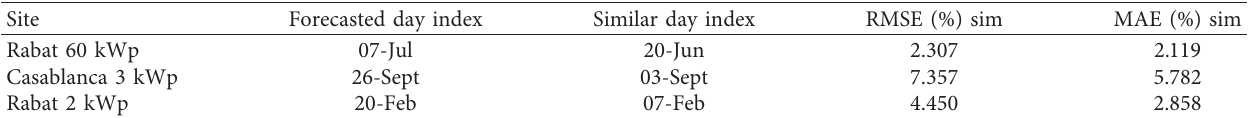
Table 10: Summary results of assessment of accuracy of similarity algorithm for each location.